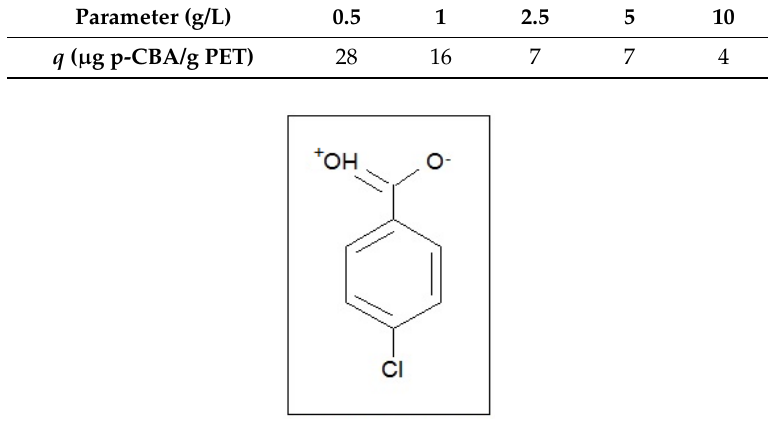
Table 4. Adsorption loading of p‐CBA ( C o = 4 μM) on different initial concentrations of PET catalyst. Figure 3. Charge of p‐CBA in ionization equilibrium. Figure 3. Charge of p-CBA in ionization equilibrium.